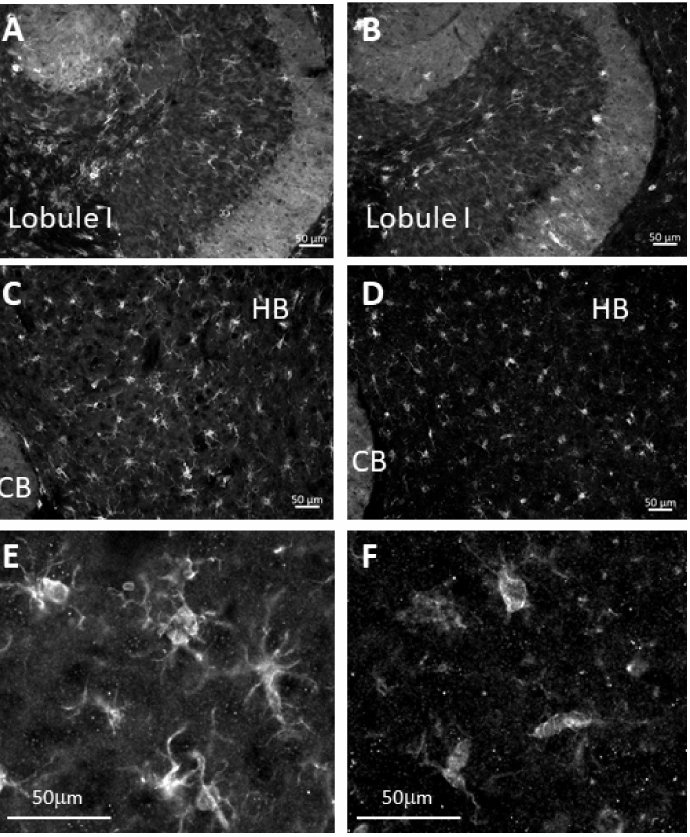
Figure 5. Immunofluorescence analysis of microglia in cerebellar sections of mutant mice. The brains of mutant mice (7 weeks old) were fixed, sectioned, and stained for Iba1. Microglia were observed